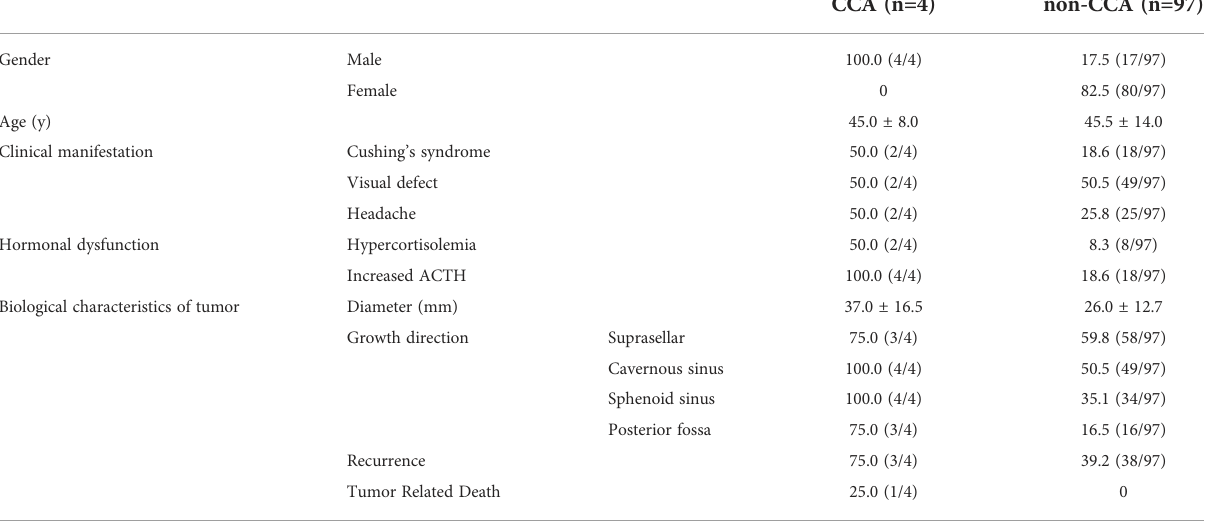
TABLE 1 Characteristics of our